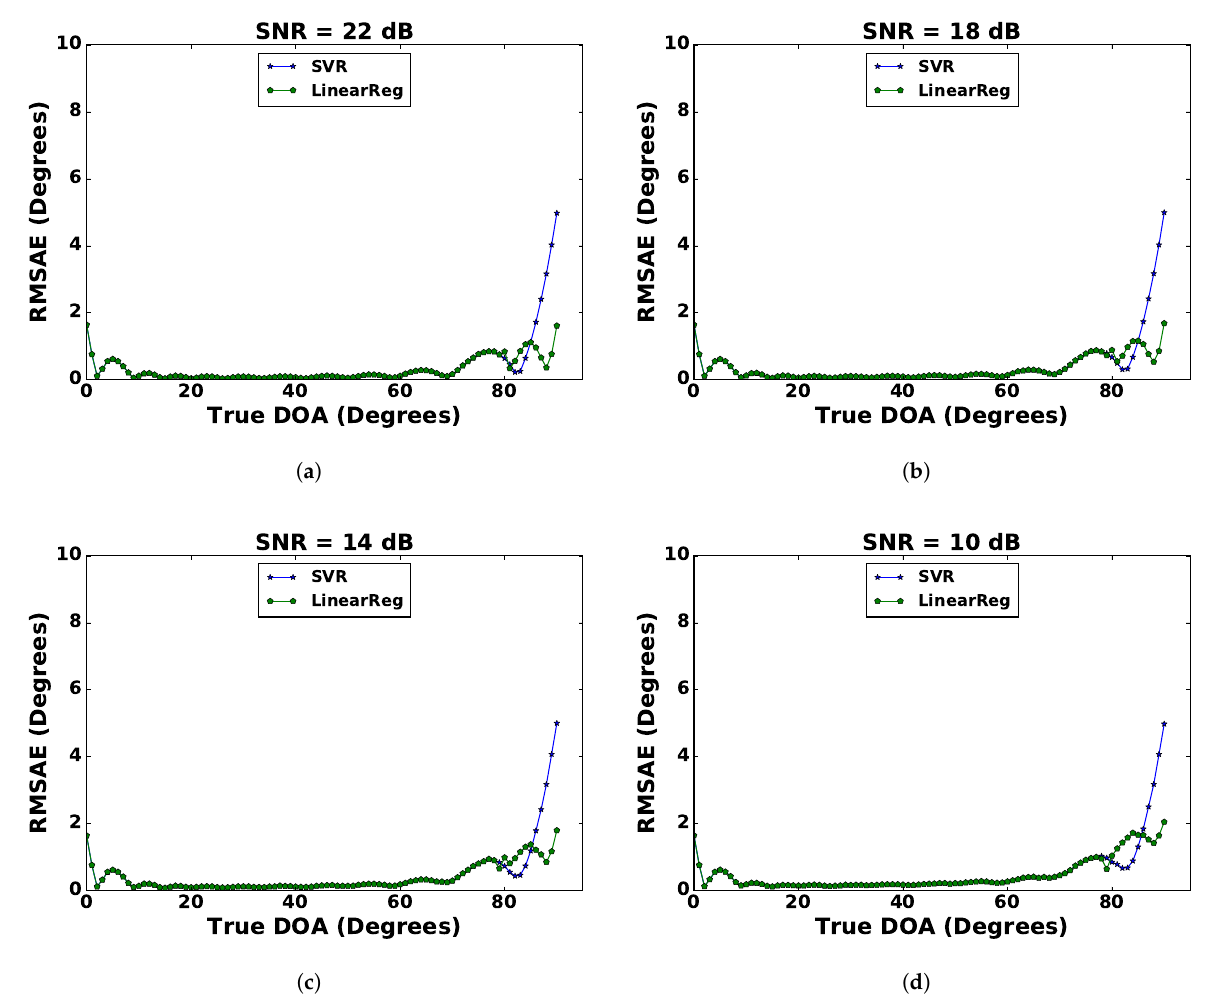
Figure 8. Comparison between SVR-CF and SVR-CF-LR for the DoA estimate in terms of the RMSAE at the end-fire for ( a ) SNR = 22 dB, ( b ) SNR = 18 dB, ( c ) SNR = 14 dB, and ( d ) SNR = 10